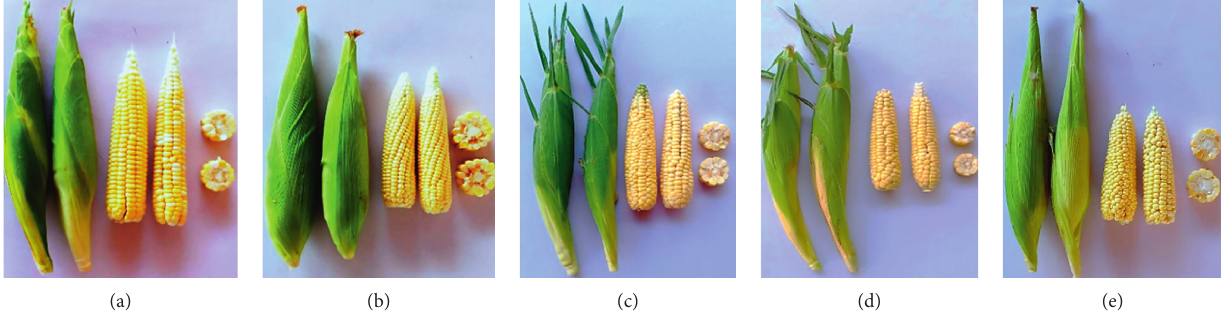
Figure 3: Appearances of both unhusked and husked corn ears of top five genotypes with a high level of lutein, zeaxanthin, beta-carotene, and total carotenoids content. (a) UT121001, (b) KKU-WX112087, (c) KKU-WX212001, (d) KKU-WX211018, and (e) KKU-WX221040.